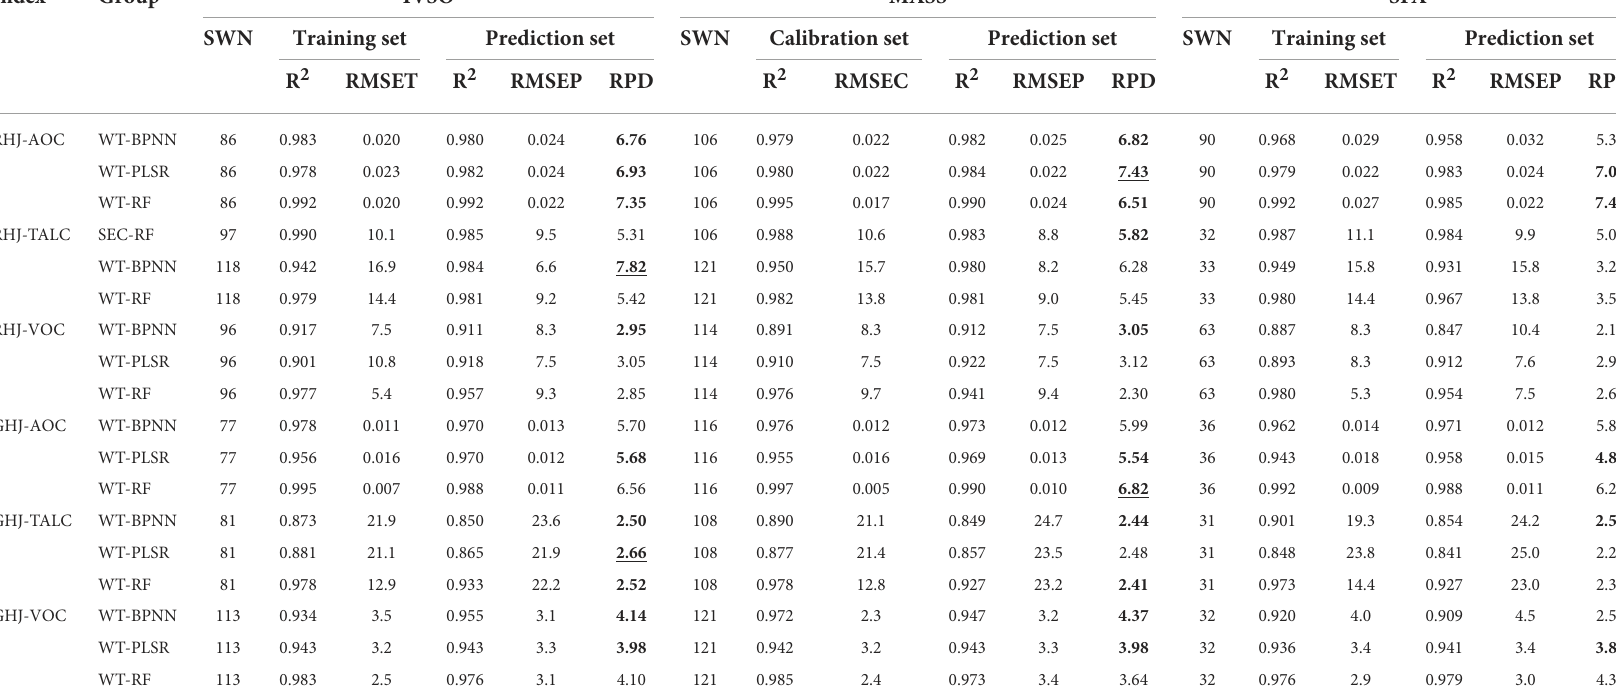
TABLE 3 Chemical indexes prediction of RHJ and GHJ based on the selected